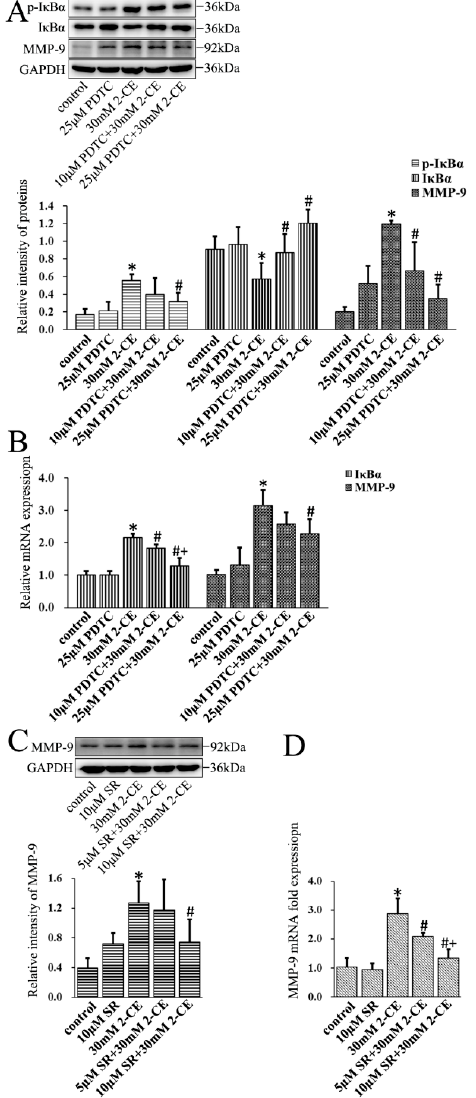
Figure 5. Role of nuclear factor kappa B (NF- κ B) and activator protein-1 (AP-1) in 2-CE induced MMP-9 overexpression in astrocytes. ( A , B ) Astrocytes were pre-treated with 10 and 25 µ M of pyrrolidine dithiocarbamate (PDTC) for 2 h and then treated with 30 mM 2-CE for 12 h; ( C , D ) Astrocytes were pre-treated with 5 and 10 µ M SR for 1 h and then treated with 30 mM 2-CE for 12 h; ( A , C ) The levels of p-I κ B α , I κ B α , and MMP-9 in astrocytes measured by Western blotting; ( B , D ) The I κ B α and MMP-9 mRNA levels analyzed by RT-PCR. ( n = 4; mean ± SD; * p < 0.05 vs. control group, # p < 0.05 vs. 30 mM of 2-CE, + p < 0.05 vs. 10 µM of PDTC or 5 µM of SR; one-way ANOVA followed by SNK tests.).